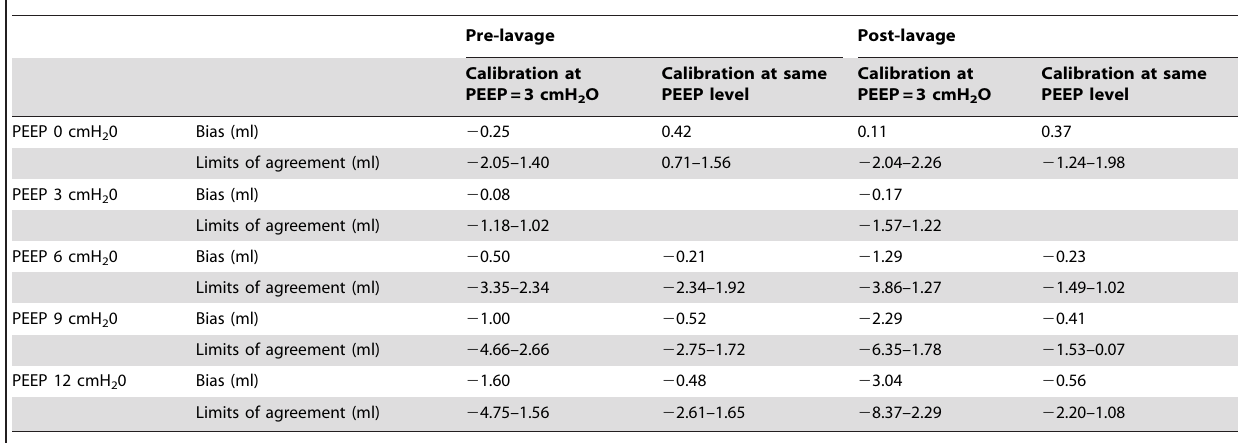
Table 2. Agreement between VT calc and VT PNT in Bland-Altman analysis.